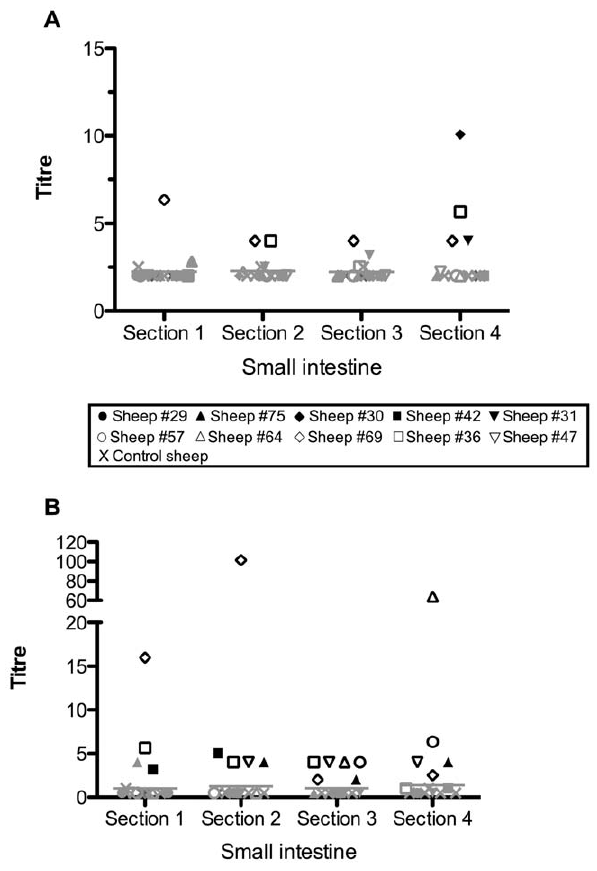
Figure 5. Relative abundance of LTB-specific IgG (A) and IgA (B) at different sections of the sheep small intestine following oral immunisation with four doses of control or LTB-transgenic plant materials. The horizontal lines represent geometric means. Black symbols denote positive responders defined as sheep with antibody titres at least three standard deviations above the control mean, non-responders are indicated by grey symbols.